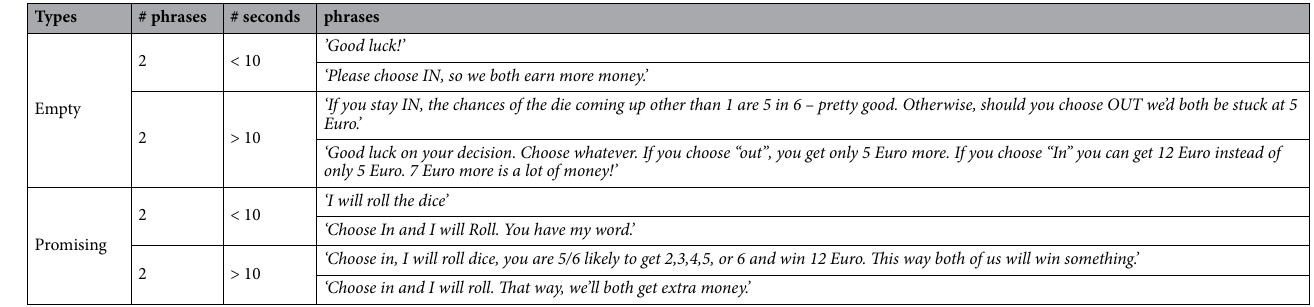
Table 2. Type of messages. This table reports 8 sentences that occured between human participants in the study of Charness and Dufwenberg (2006) and were selected in our study. 4 out of 8 sentences were classified as short (i.e. they last less than 10 s) and empty (i.e. they did not contain any type of promise to roll the